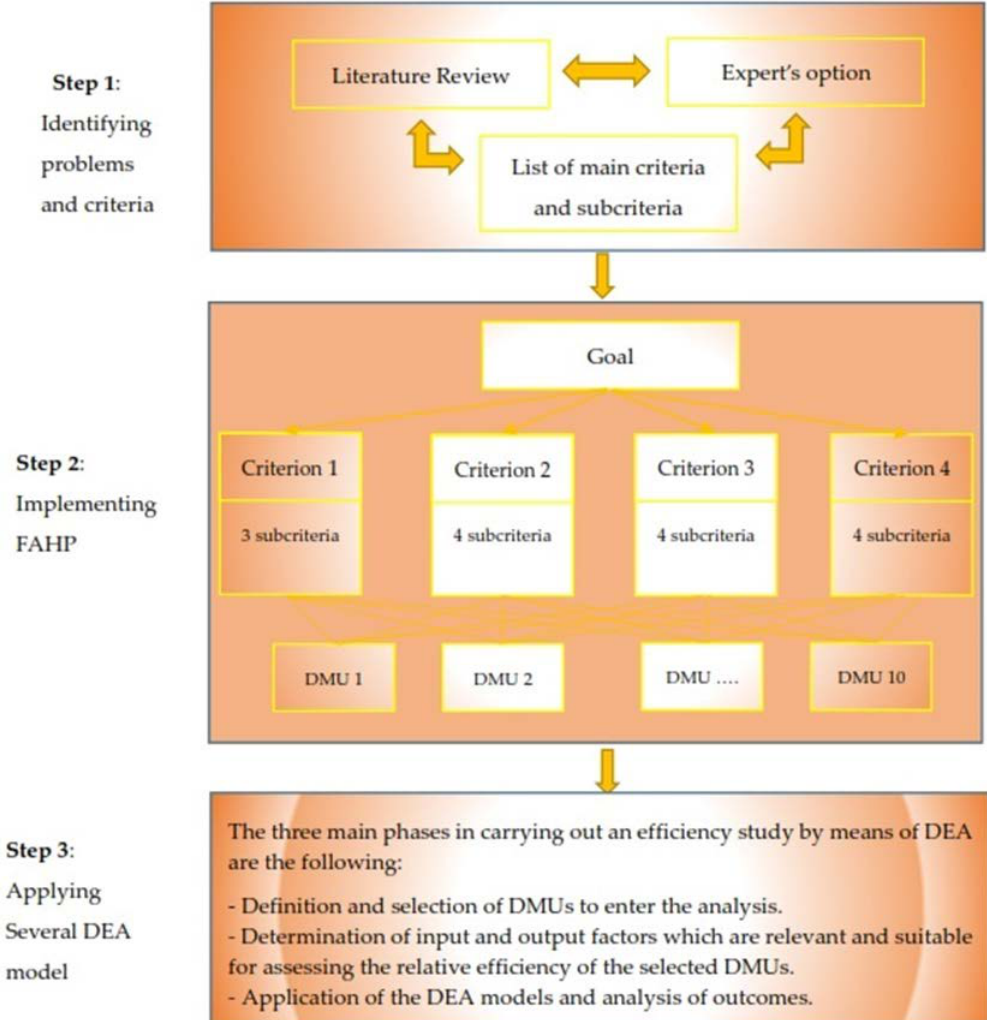
Figure 2. Research process. DMU: Decision-making unit. DEA: Data envelopment analysis.